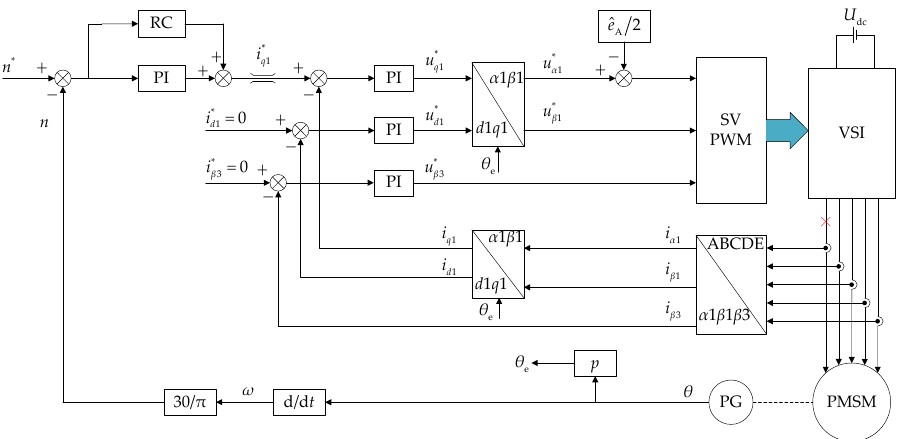
Figure 12. Fault-tolerant control system of five-phase PMSM under ITSC